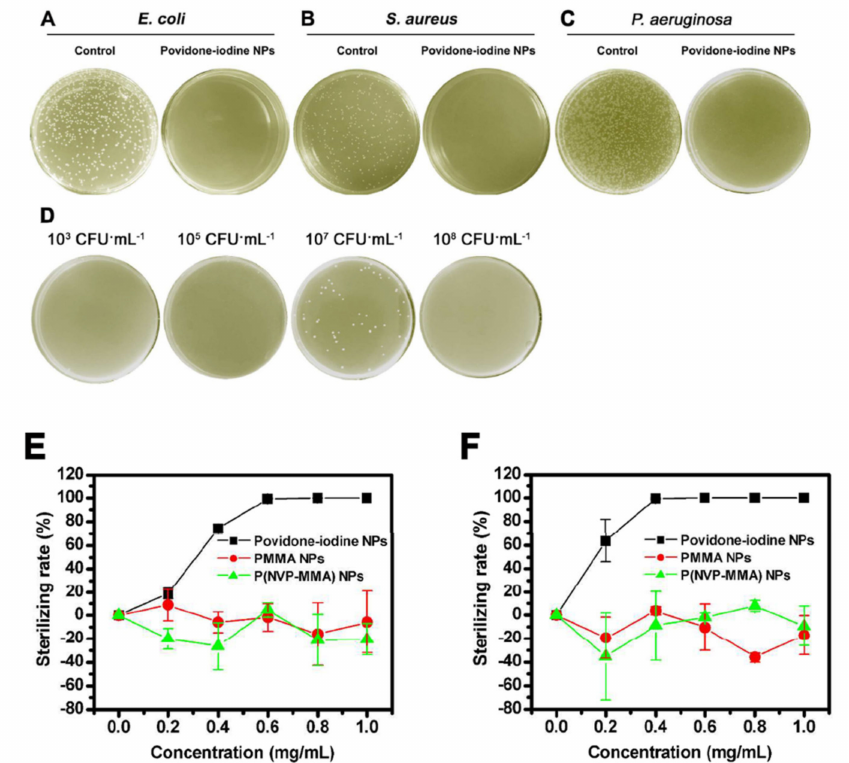
Figure 7. Photographs for the bacterial culture plates of E. coli ( A ), S. aureus ( B ), and P. aeruginosa ( C ) upon a 30 min exposure of povidone-iodine NPs. ( D ) Photographs for the bacterial culture plates of E. coli with different concentration upon a 30 min exposure of povidone-iodine NPs. Effect of povidone iodine NPs concentration on their antibacterial activity against E. coli ( E ) and S. aureus ( F ). Reproduced with permission from [131], ACS Publications,